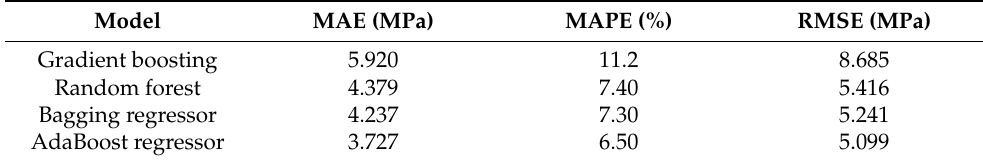
Table 2. Statistical evaluation of the techniques used.